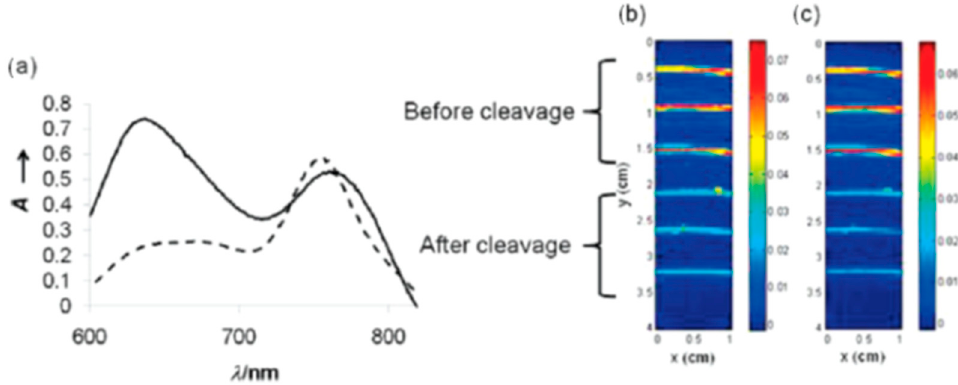
Figure 13. Quencher-based MMP-2 probe cleavage. ( a ) Absorbance spectra from before (solid line) and after (dashed line) MMP-2 activation of the probe. Optoacoustic imaging of probe before and after cleavage at 675 ( b ) and 750 nm ( c ). Figure from [93] reproduced with permission from the publisher.